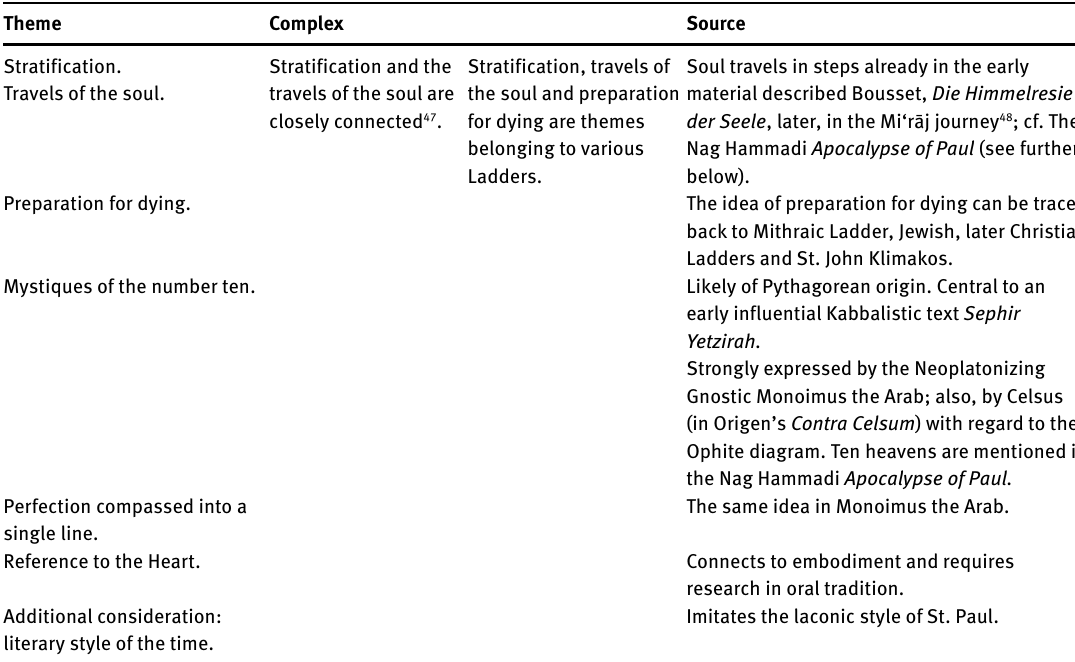
Table 2. Structural Thematic Analysis of Ideas in Theophanis’